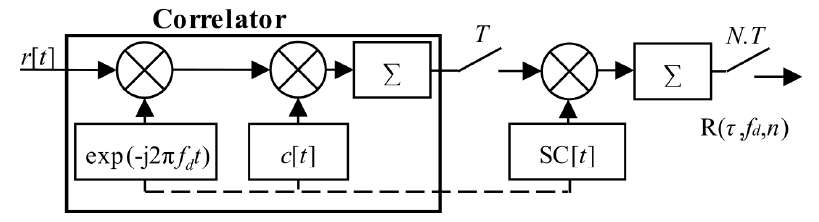
Figure 2 . Sequential search acquisition schema . Figure 2. Sequential search acquisition